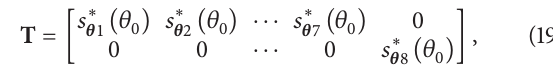
the array to form the quiescent beam and the central element as an omnidirectional retrodirective